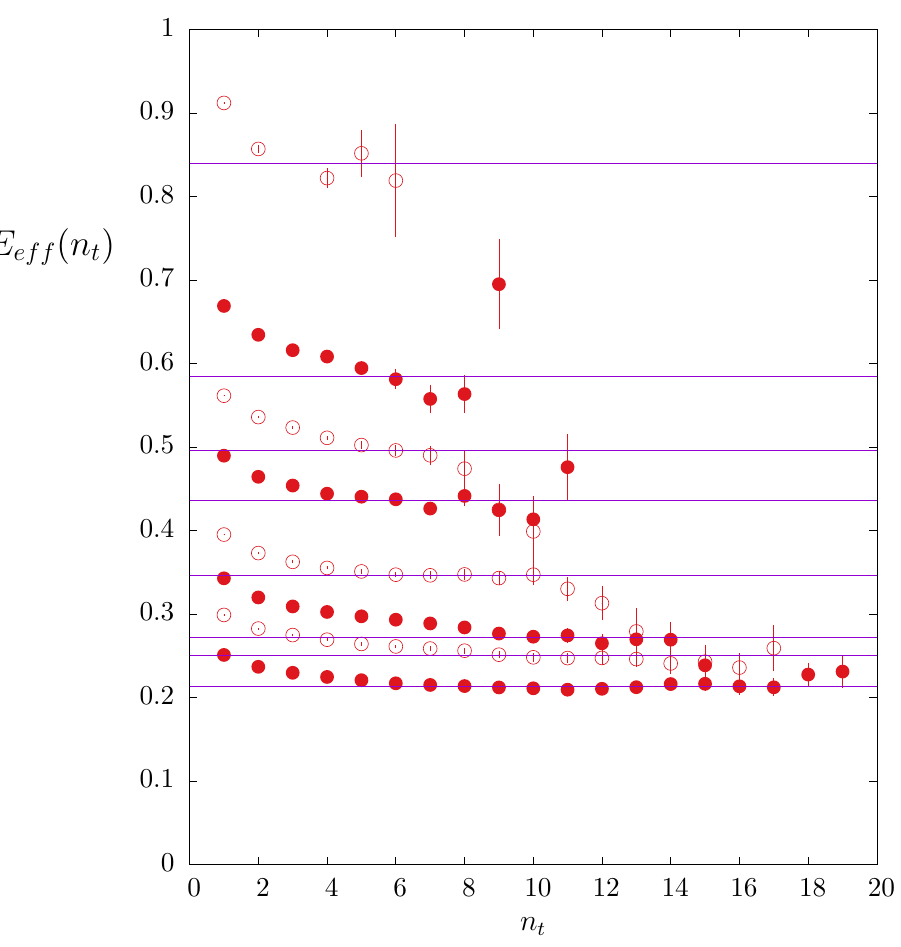
Figure 15 . E(cid:11)ective energy of a (cid:13)ux tube of length l in SO(3) at (cid:12) = 9 : 0, as a function of n t = t=a for l = 26 ; 30 ; 34 ; 38 ; 46 ; 52 ; 62 ; 82. Correlators not vacuum subtracted. Lines represent our energy